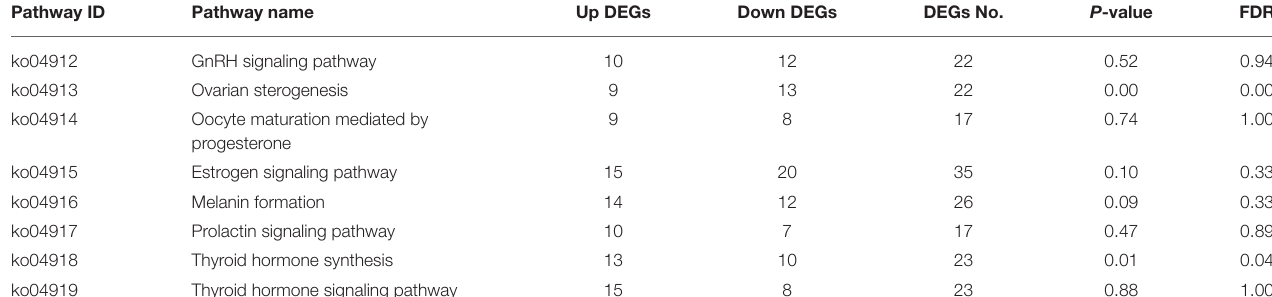
TABLE 8 | Metabolic pathways related to reproductive hormones in ovary of Zi-geese. Pathway ID